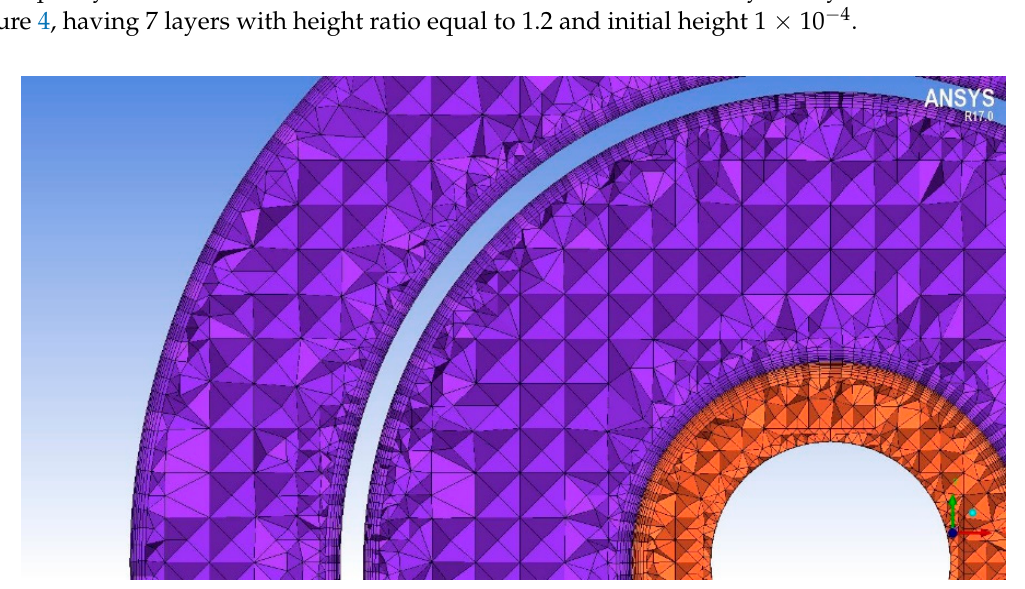
Figure 4. Layer additions near the wall in the fluid domain.